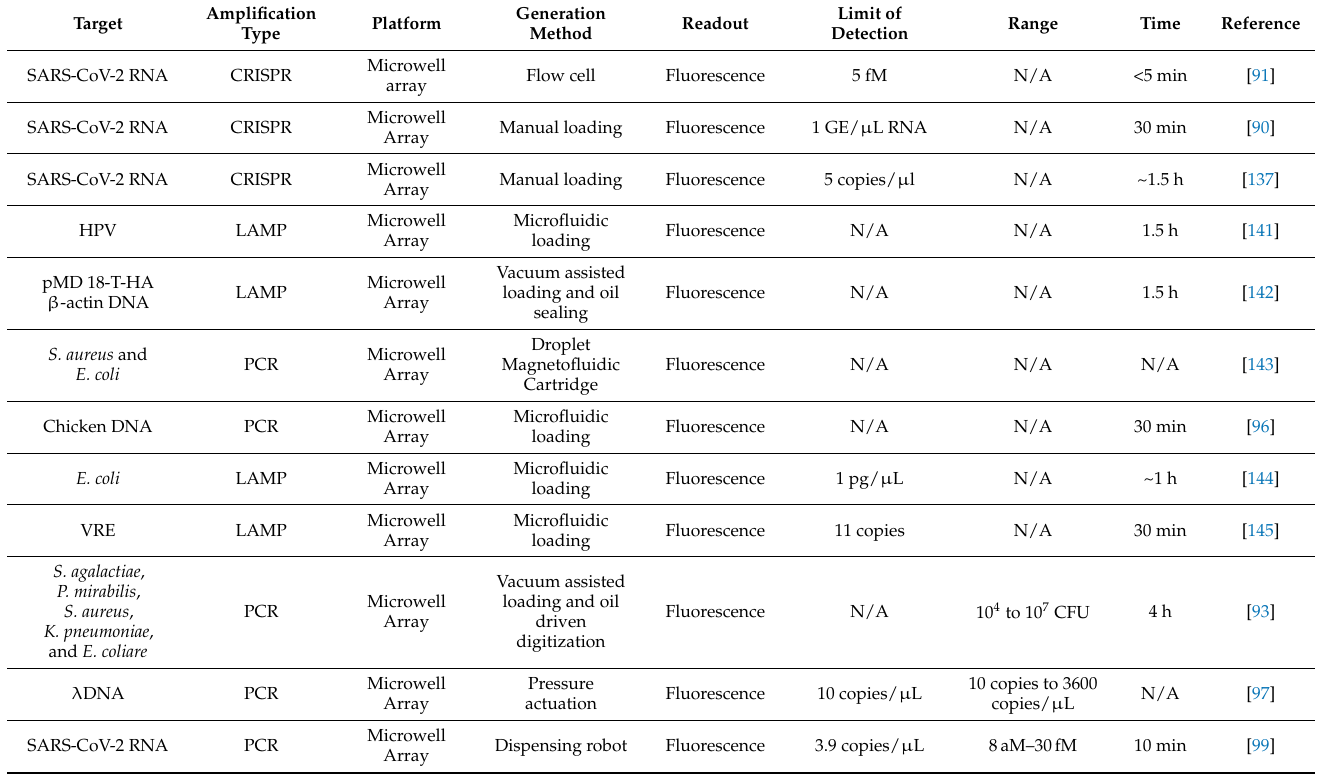
Table 2. Summary of digital nucleic acid detection